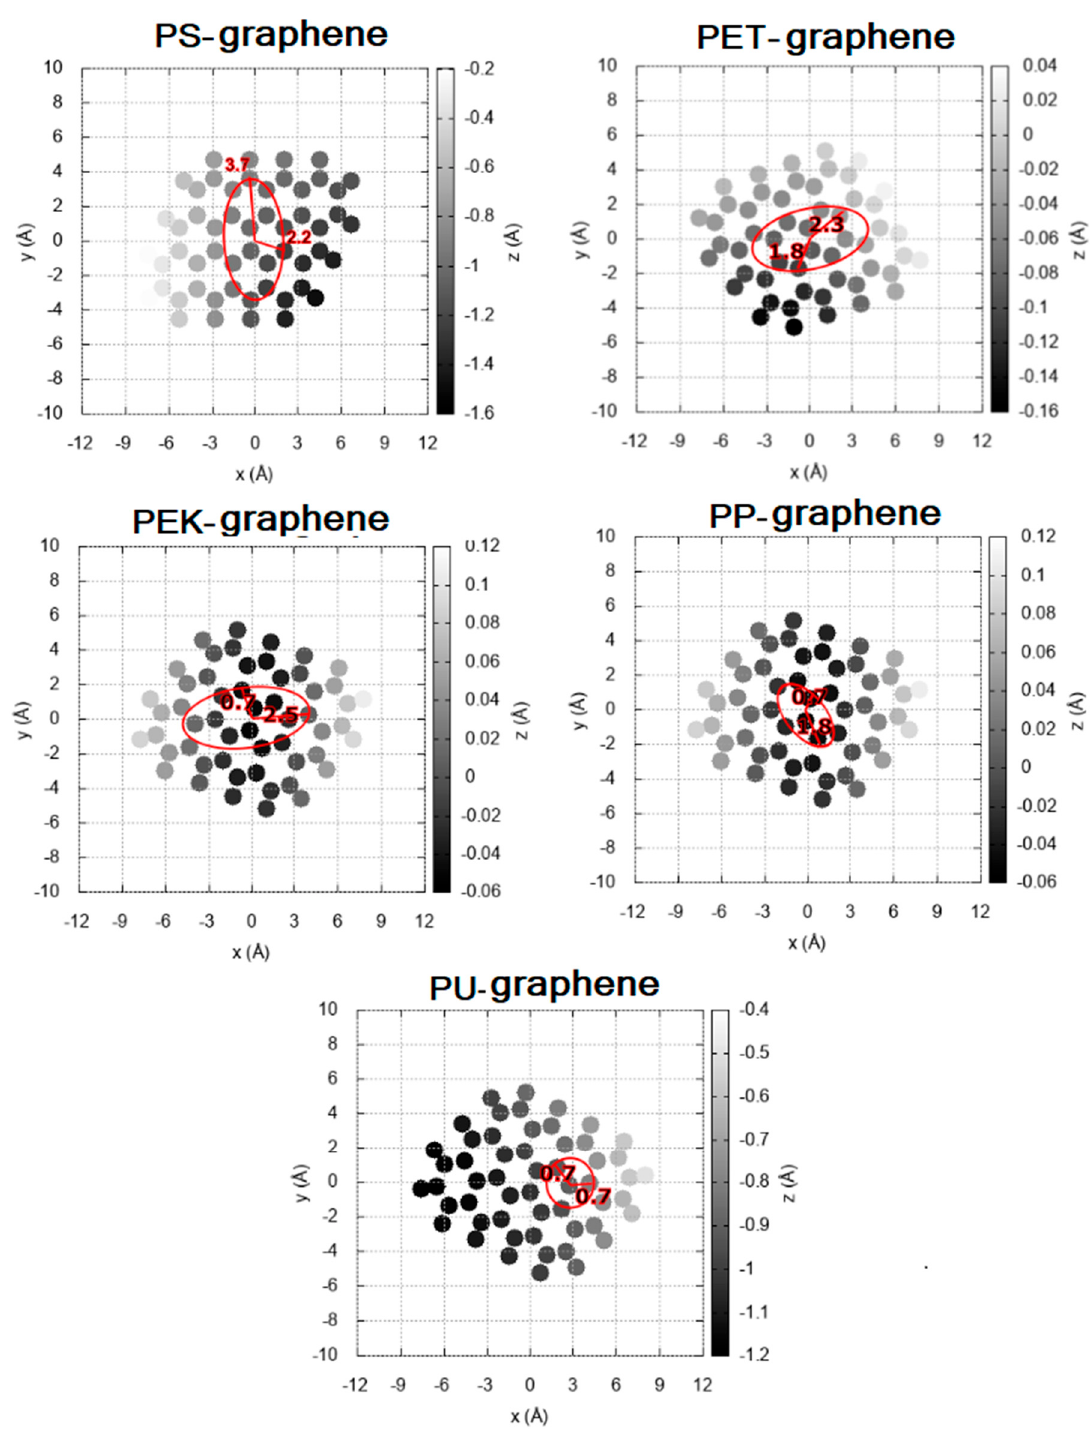
Figure 3. Action radius of the most stable configuration of the systems under